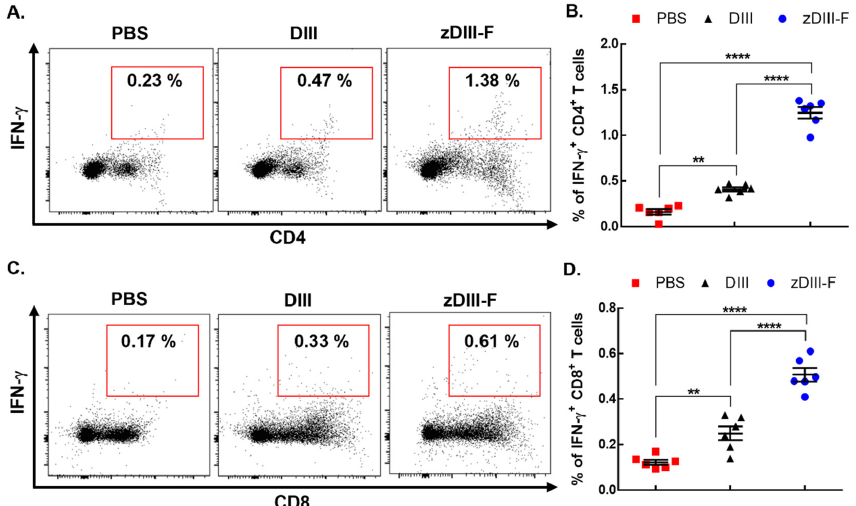
Figure 4. zDIII-F vaccine candidate induces potent cellular immune response in vaccinated mice. BALB/c mice (n = 6) were administered either PBS, DIII or zDIII-F. Spleens were harvested at 21